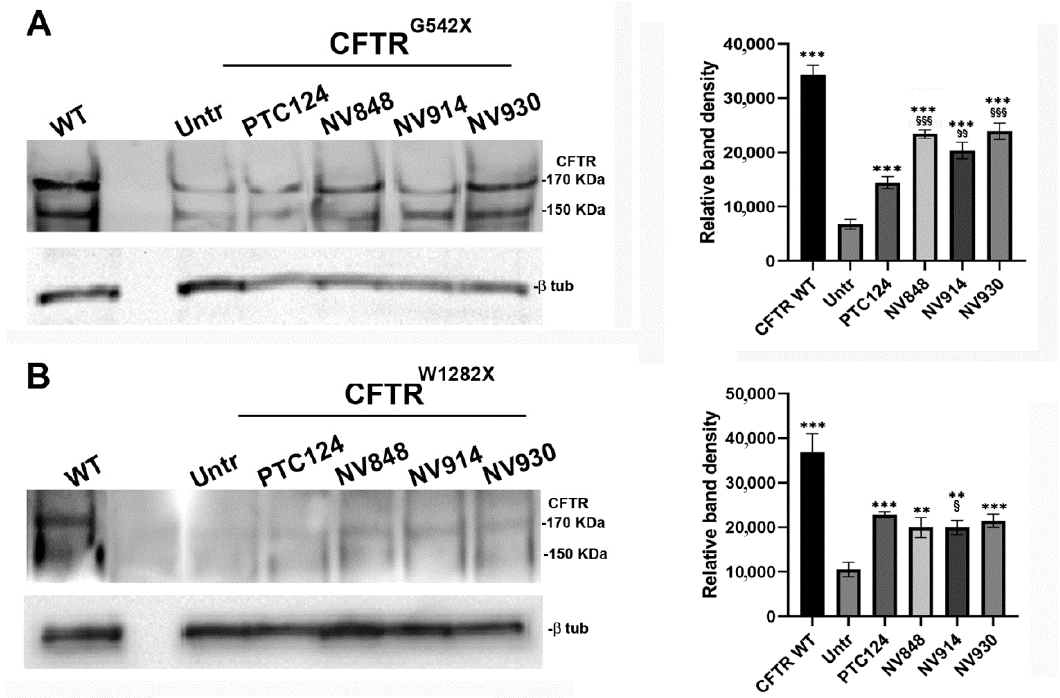
Figure 8. Western blot analysis of the CFTR protein in wild-type (WT) CFTR, and CFTR G542X ( A ) and CFTR W1282X ( B ) FRT cells, untreated (Untr) or treated with 12 µ M PTC124 (positive control), NV848 , NV930 , or NV914 for 24 h; β -tubulin was used as control for the protein loading. The graphs show the quantification of the gel bands by ImageJ software. The experiment was performed in triplicate and data were normalized by β -tubulin expression, analyzed by GraphPad Prism 6 software. Data are expressed as mean values ± standard error of the mean (SEM). Symbols (* and §) represent the statistical significance of NV848 , NV914 , and NV930 versus Untr (*) and versus PTC124 (§). two symbols, p < 0.01; three symbols, p < 0.001 (Student’s t -test and ANOVA with Dunnett’s posthoc